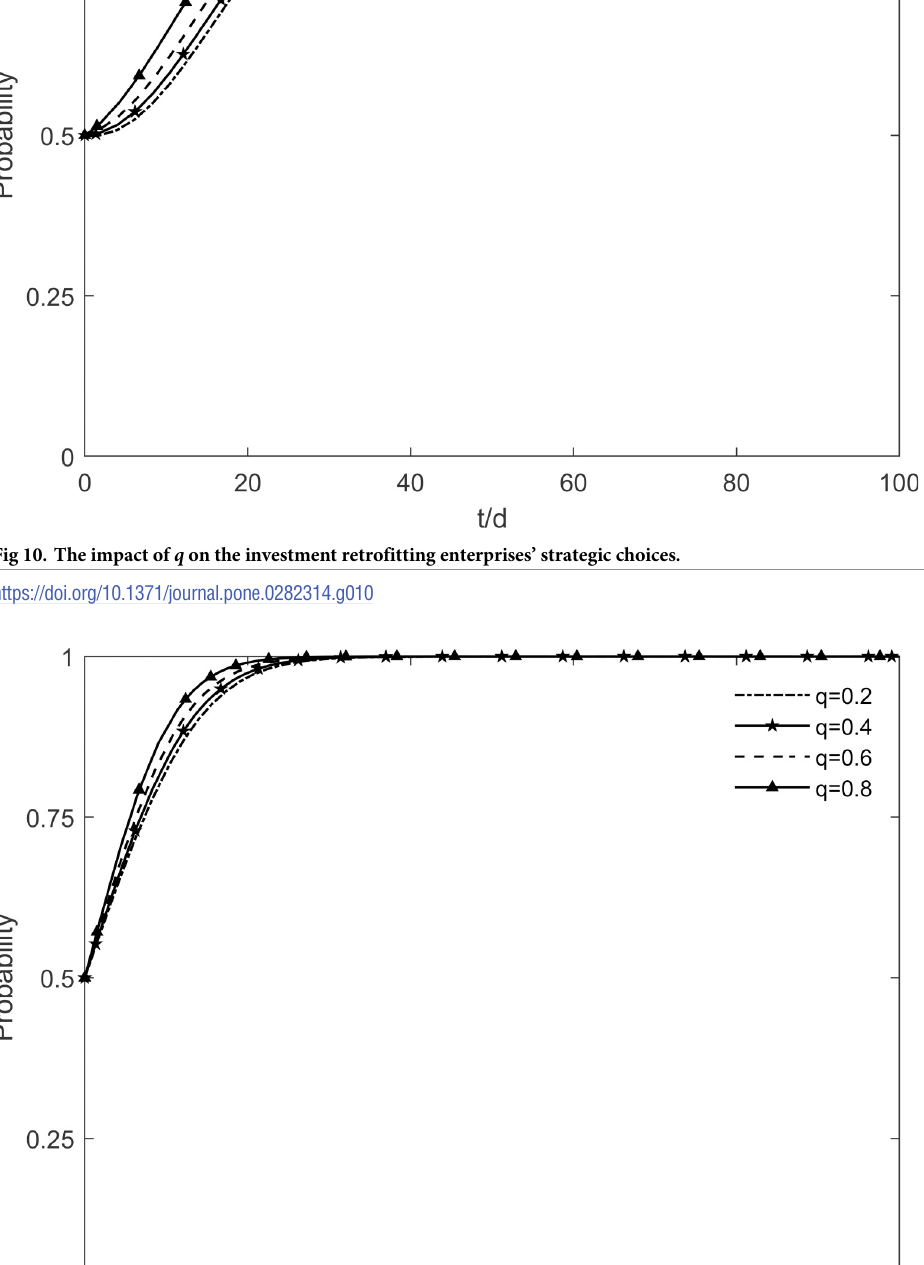
PLOS ONE | https://doi.org/10.1371/journal.pone.0282314 March 16,